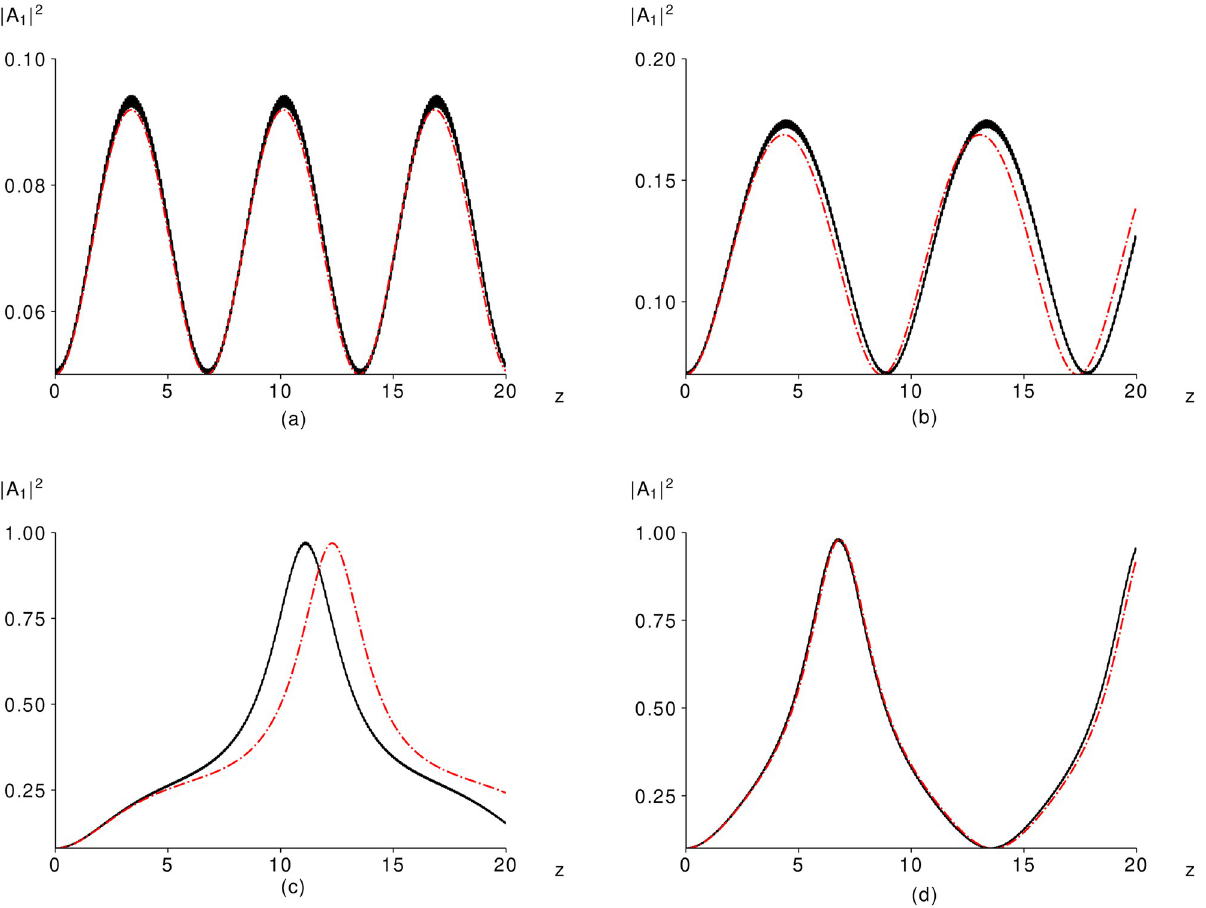
Fig 2. Computer simulation results obtained on the base of both the original problem (black solid lines) and the modified problem (red dashed-dotted lines) computed for the parameters: γ = 4, Δ 21 k = 80, | A 20 | 2 = 0, φ 0 = 0 and | A 10 | 2 = 0.05 (a), 0.07 (b), 0.08 (c), 0.1 (d).